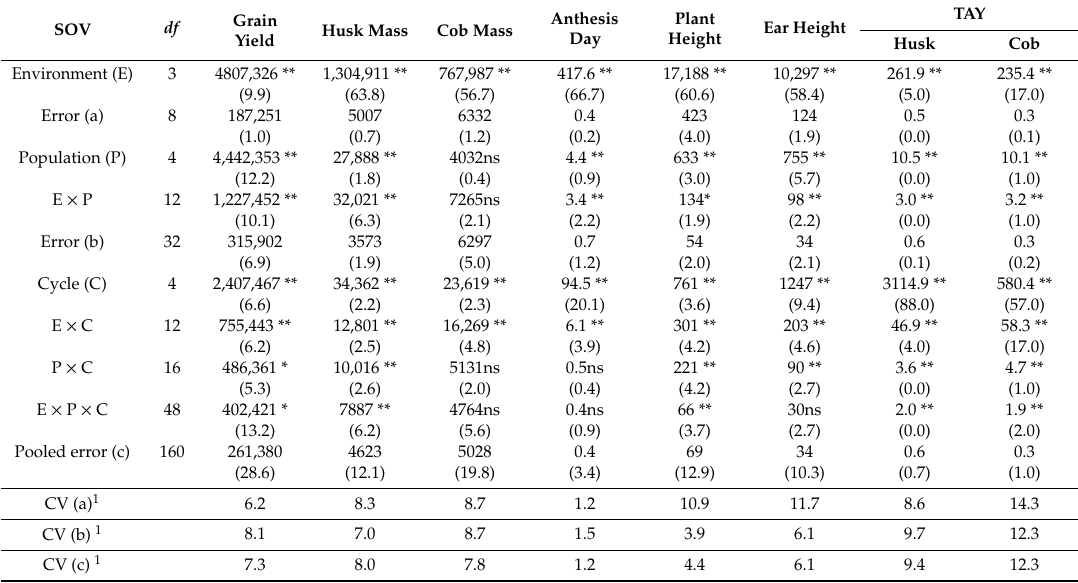
Table 3. Mean squares for grain yield, agronomic traits and total anthocyanin yield (TAY) of five populations and five cycles evaluated across four environments. SOV